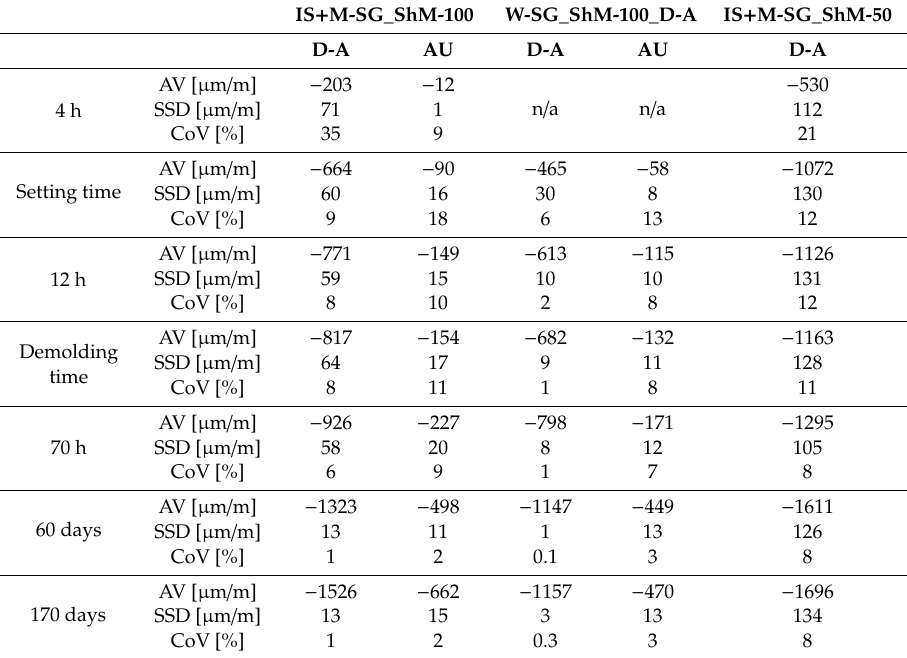
Table 3. Shrinkage values of the SCC HPC: Average value (AV), sample standard deviation (SSD), coe ffi cient of variation